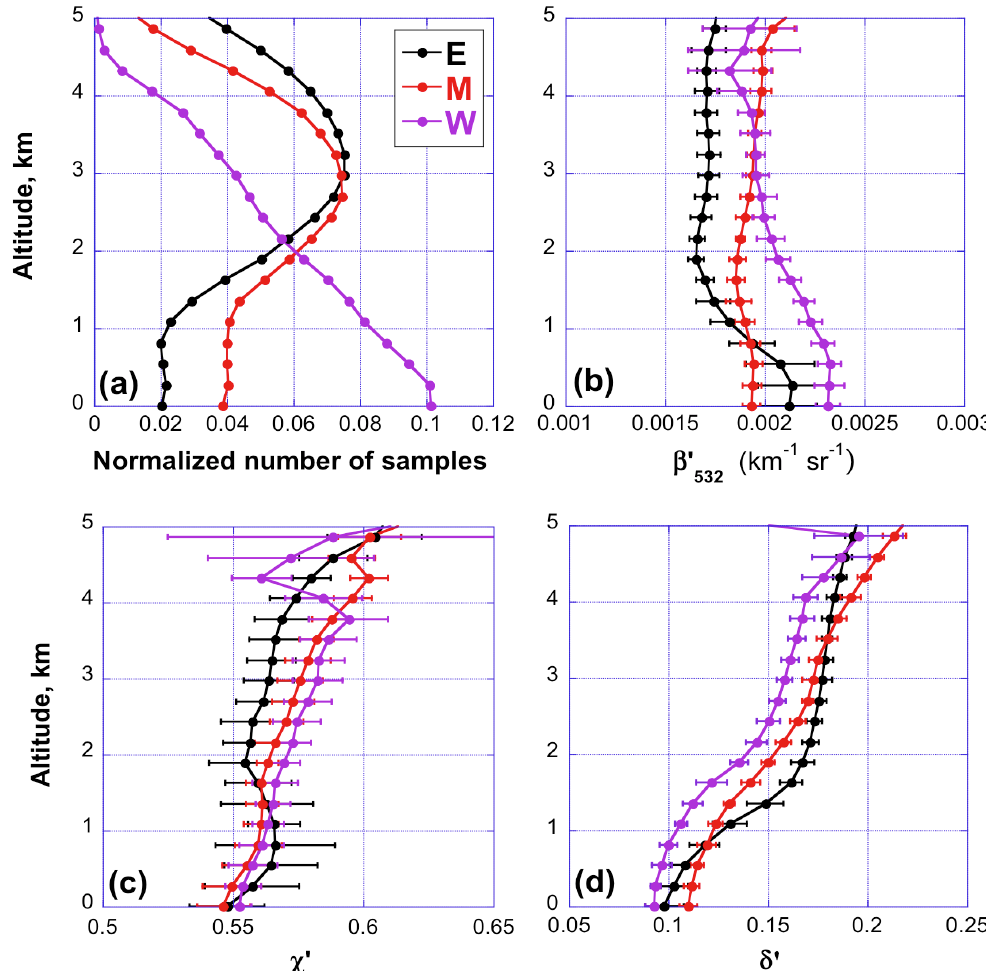
Fig. 2. Vertical profiles of (a) number of 5km-resolution dust samples, normalized by the total number of dust samples at each corresponding region. The total number of dust samples is 45714 for E, 73141 for M and 32785 for W. In addition, the E, M, and W regions contain 24701, 34019, and 23786 5 km-resolution vertical profiles over ocean, respectively. (b) median attenuated total backscatter coefficient at 532nm, β 0 , (c) median attenuated color ratio, χ 0 , (d) median volume depolarization ratio, δ 0 . The colors identify the profiles for each study region (East, Middle, and West). The error bars indicate the uncertainty of median values, estimated using the bootstrap algorithm.